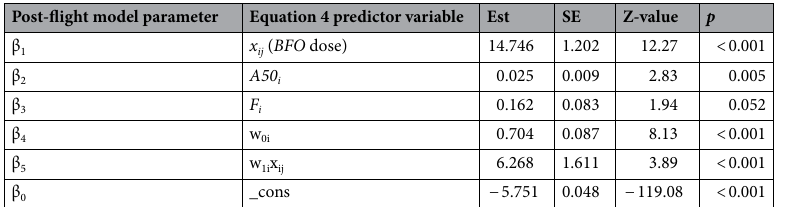
Table 3. Post-flight in-vivo poisson regression parameter estimates (“Est.”) and standard errors (“SE”) based on all post-flight observations with BFO doses ranging from 0.01 to 0.04 Gy as well as baseline pre-flight observations. Besides age and gender, predictors in this model included predicted values of baseline random subject-specific perturbations to CAR (w 0i ) as well as predicted values of subject-specific perturbations to radiosensitivity (w 1i x ij ).